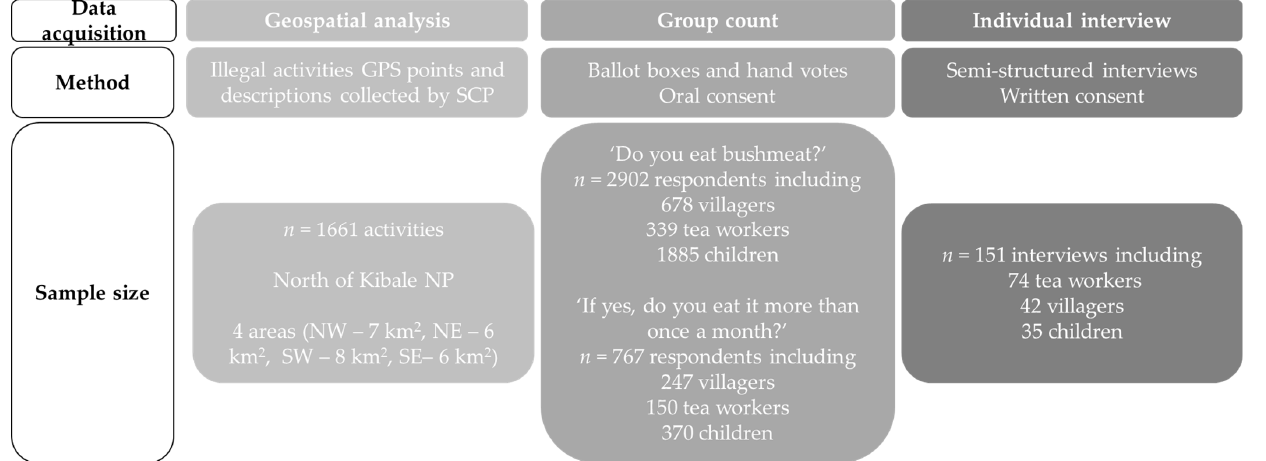
Figure 1. Data acquisition types, collection methods, and sample sizes used in determining spatial distribution of illegal activities and wild meat consumption analyses in Sebitoli area, Kibale National Park, Uganda.